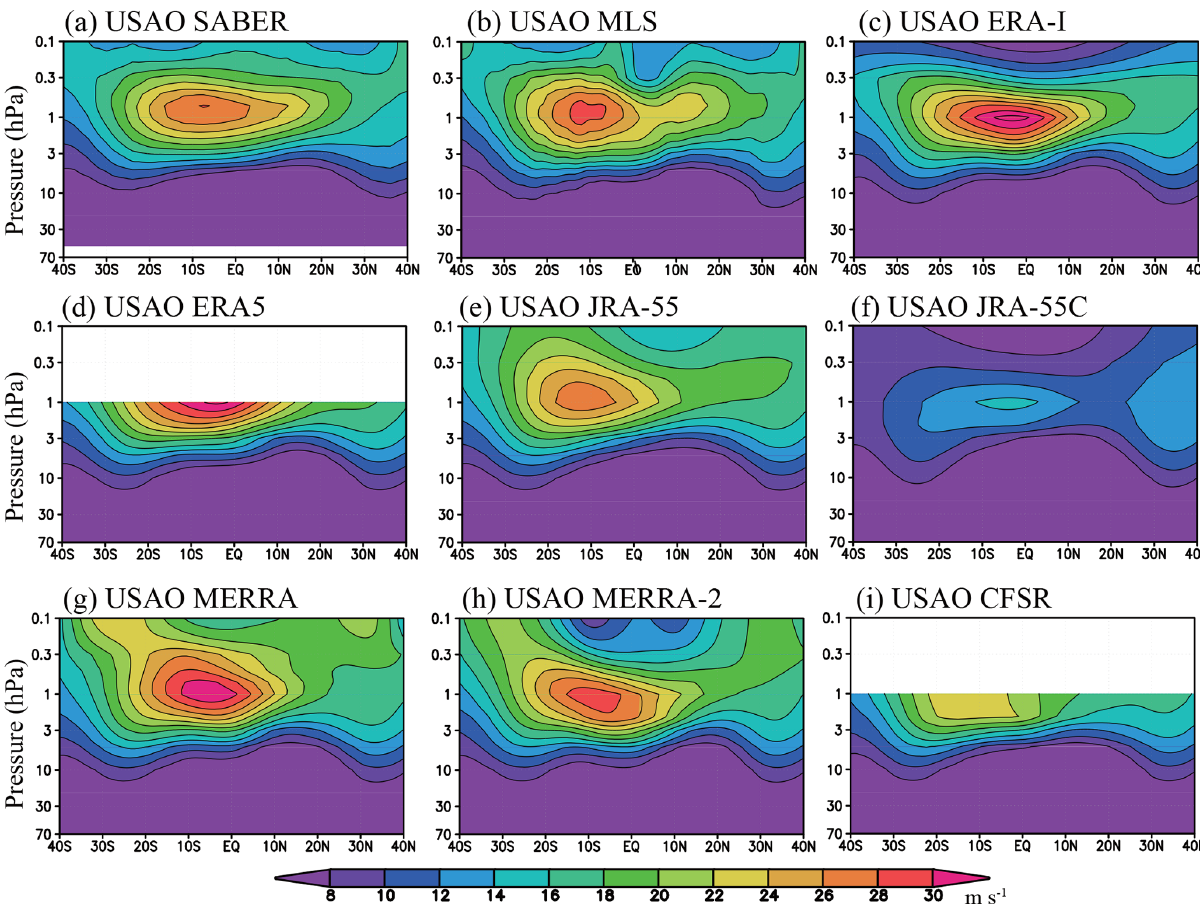
Figure 11. Latitude–height cross section of amplitude of the SAO in zonal wind. Color intervals are 2ms − 1 . The amplitude is calculated from 1980 to 2010 in the reanalyses, from 2002 to 2016 in SABER, and from 2005 to 2016 in